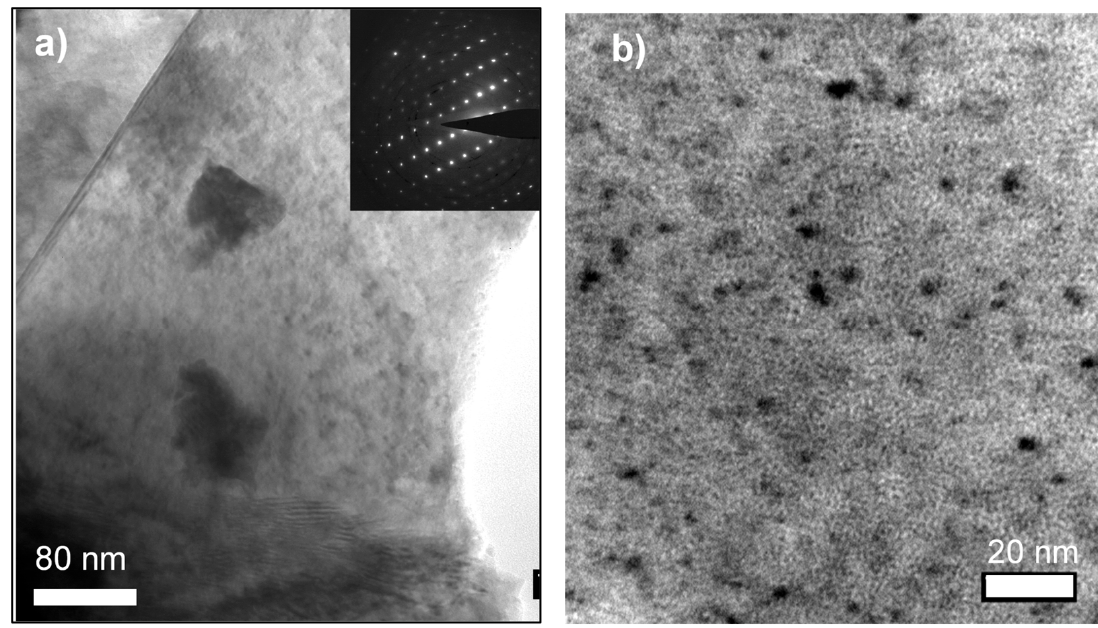
Figure 5. TEM bright field micrographs of the SF2 sample (1.3 dpa) showing: ( a ) Flat area oriented by the [110] axis showing dislocation loops (dark, circular marks); inset image is the electron diffraction proving the orientation. ( b ) Higher magnification of dislocation loops with sizes ranging from several nanometers up to ten nanometers (dark marks), together with nanometric over-focused (dark, round spots) and under-focused (light, round spots) helium bubbles.